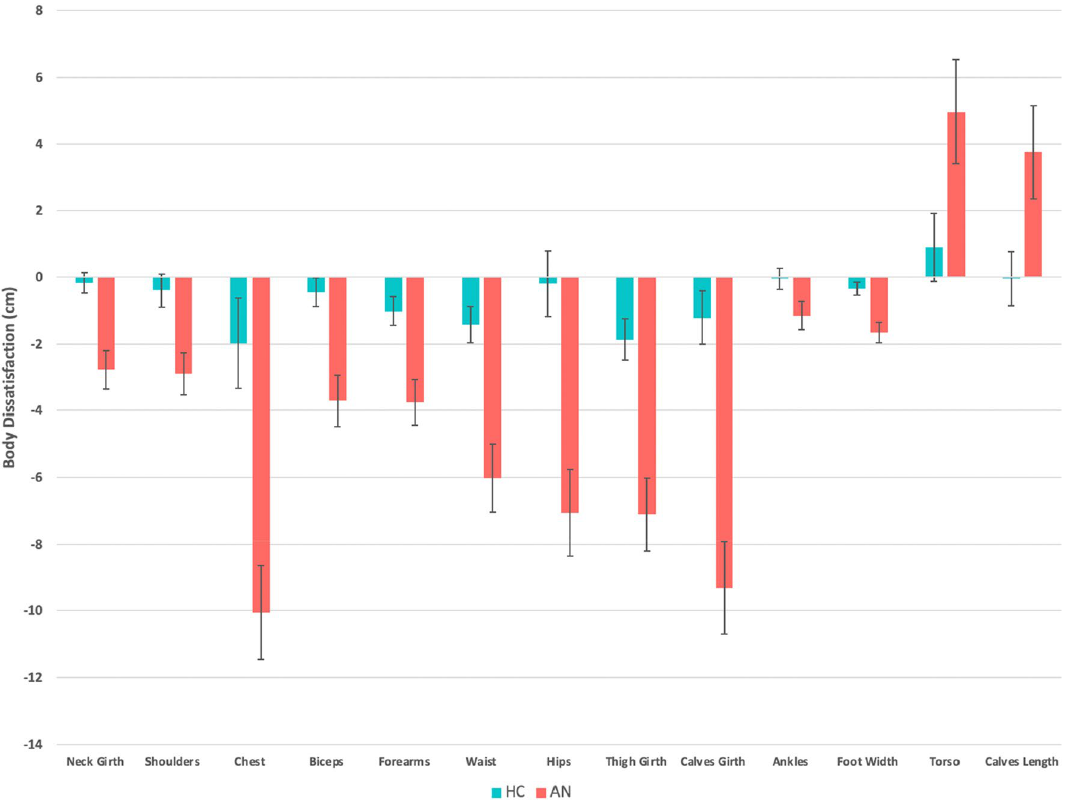
Figure 4. Body Dissatisfaction Score (ideal minus current perceived (cm)) in female AN and HC groups. All body parts refer to girth except where indicated for length. Of the total set of 23 body part measurements only those showing significant differences are displayed ( P < 0.05, corrected for multiple comparisons using the Benjamini–Hochberg procedure). Standard errors are represented by error